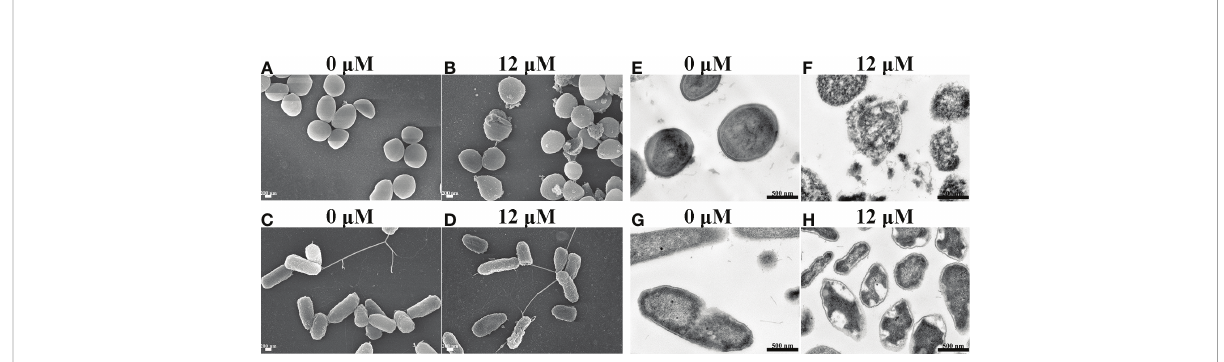
FIGURE 6 Electron micrographs of S. aureus and P. aeruginosa . Scanning electron micrographs of S. aureus treated with NaPB (A) or Spgillcin 177 – 189 (B) ; scale bars, 200 nM. Scanning electron micrographs of P. aeruginosa treated with NaPB (C) or Spgillcin 177 – 189 (D) ; scale bars, 200 nM. Transmission electron micrographs of S. aureus treated with NaPB (E) or Spgillcin 177 – 189 (F) ; scale bars, 500 nM. Transmission electron micrographs of P. aeruginosa treated with NaPB (G) or Spgillcin 177 – 189 (H) ; scale bars, 500